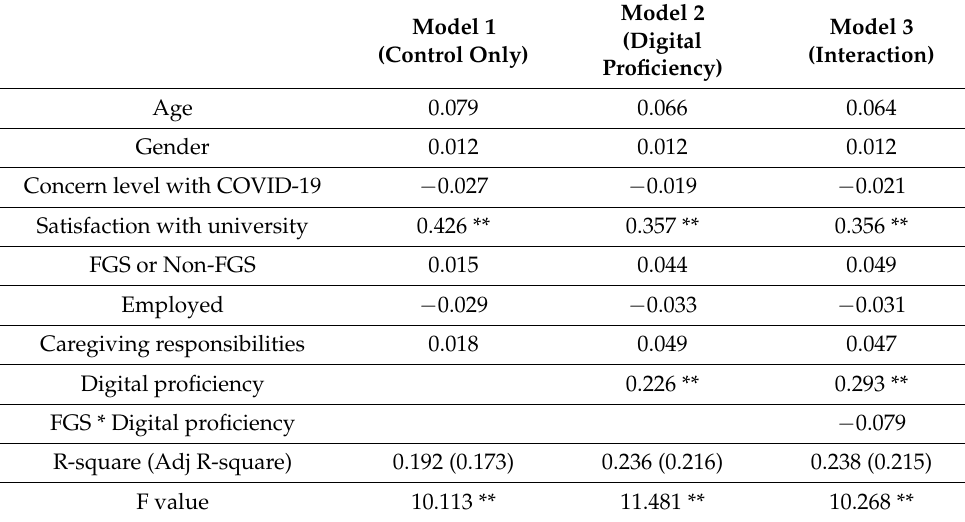
Table 5. Regression on psychological well-being for the whole